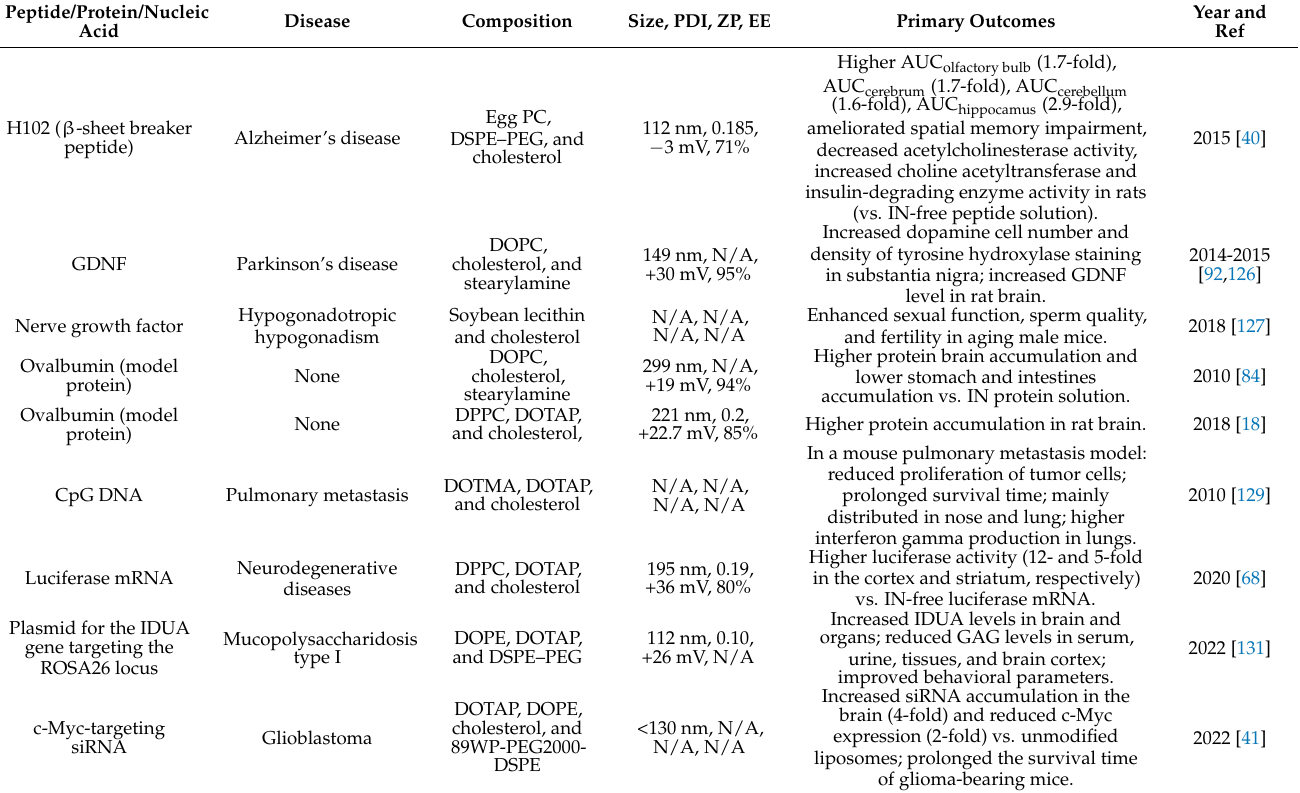
Table 2. Major features of intranasal liposomes of therapeutic peptides, proteins, and nucleic